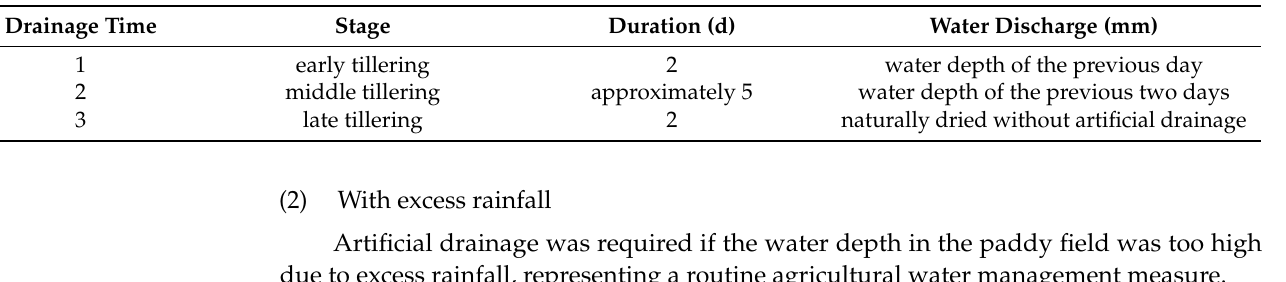
Table 4. Description of three drainage events of the paddy